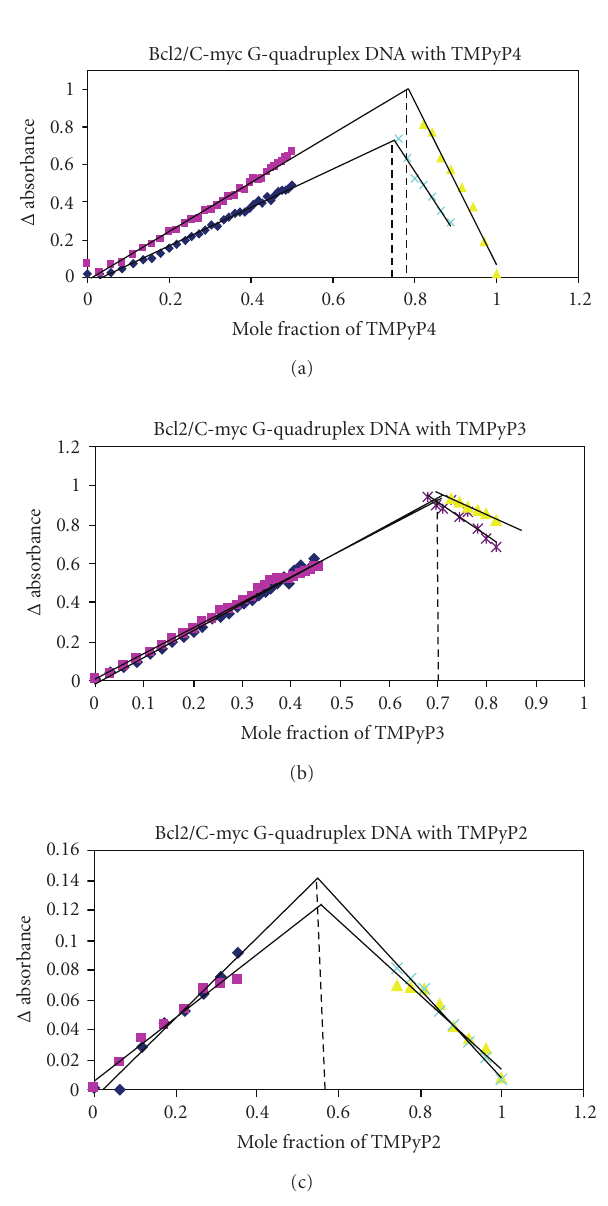
Figure 3: Job plots for the titration of the 27Bcl2 mid promoter and C-myc quadruplex DNA on interaction with TMPyP2, TMPyP3, and TMPyP4 drugs. Point of intersection of two lines is indicated by a dashed